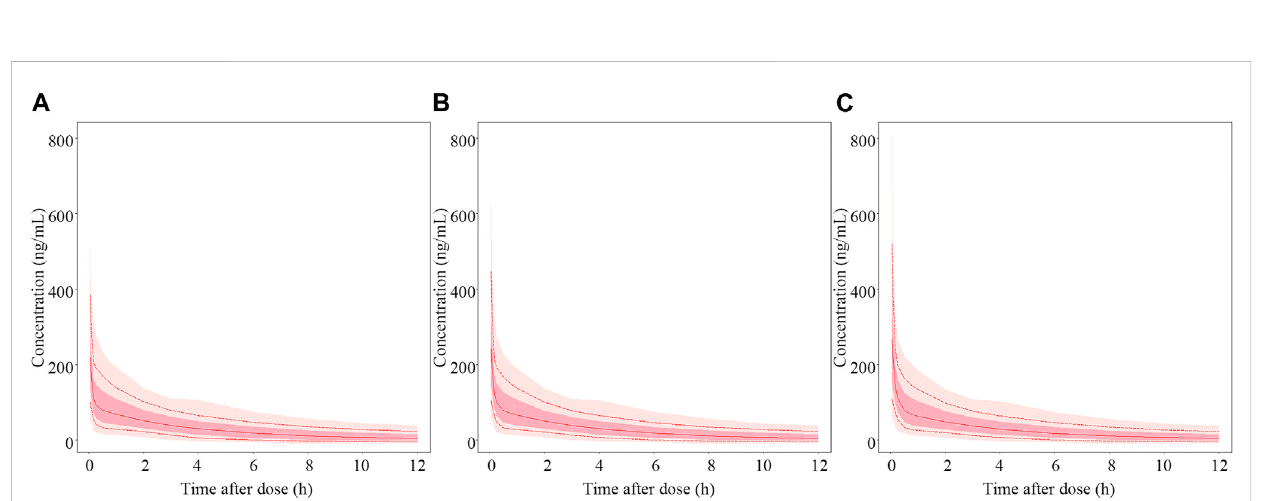
FIGURE 7 SimulatedPKpro fi lesofnalbuphine.Themedianhourlynet fl uidvolumeinfused(HNF)ofpatientinthemodelbuildinggroupwas563.6 mL/h. (A – C) represent PK pro fi les of nalbuphine at the 10th, 50th and 90th percentile of HNF levels, respectively. The solid lines represent the median values of 1,000 simulations. The whole shadow and dark shadow represent all simulations and 5% to 95% simulations of the corresponding population in each panel,